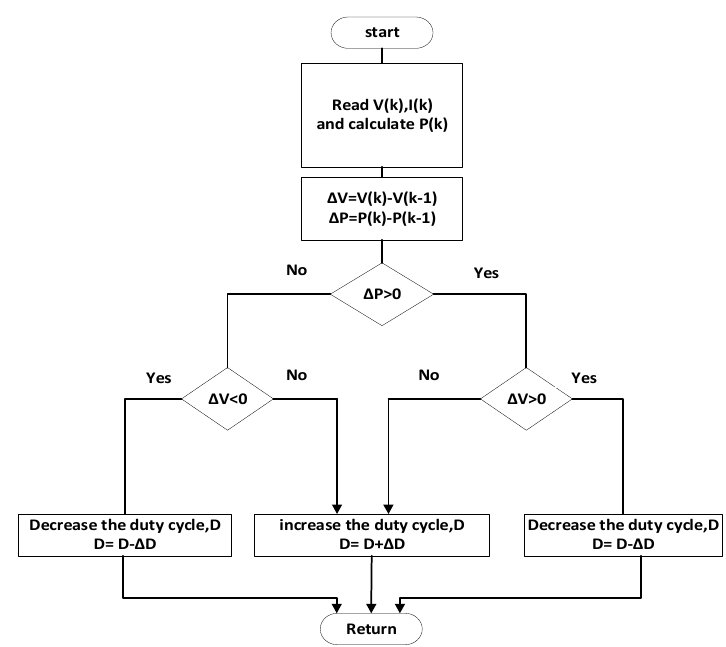
Figure 7. The control system of the proposed inverter.